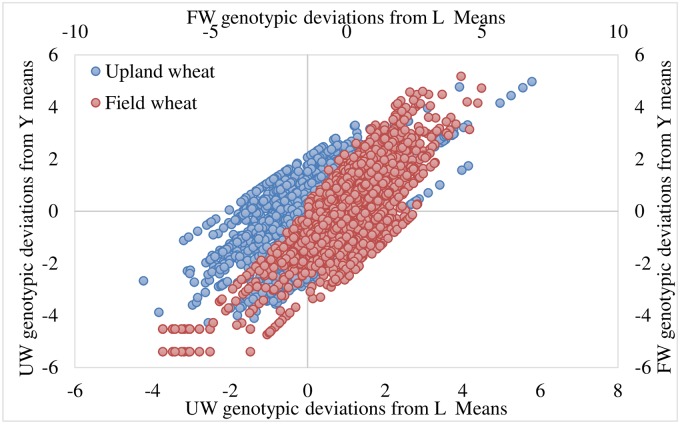
Mean genetic deviations obtained in the second cycle.